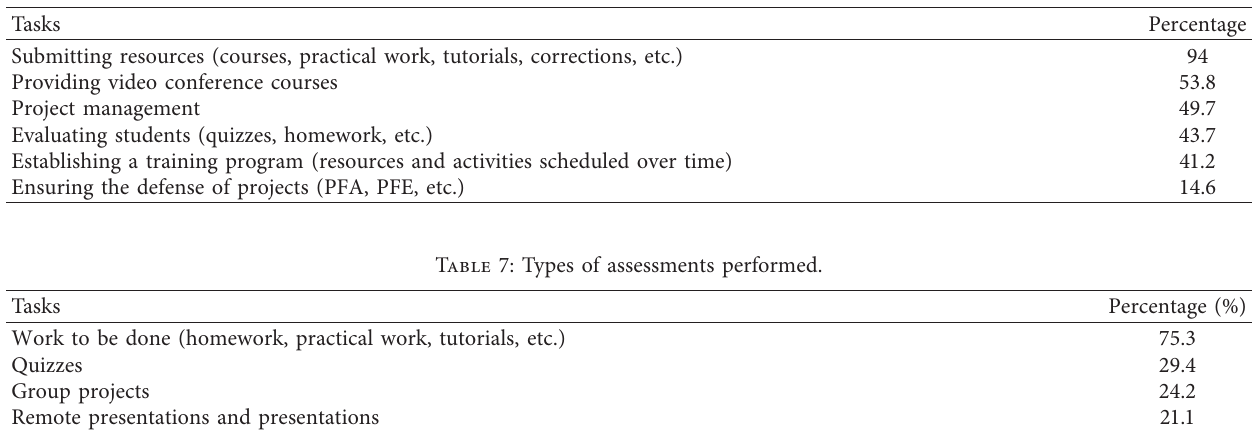
Table 6: Reasons behind the use of distance learning platforms.